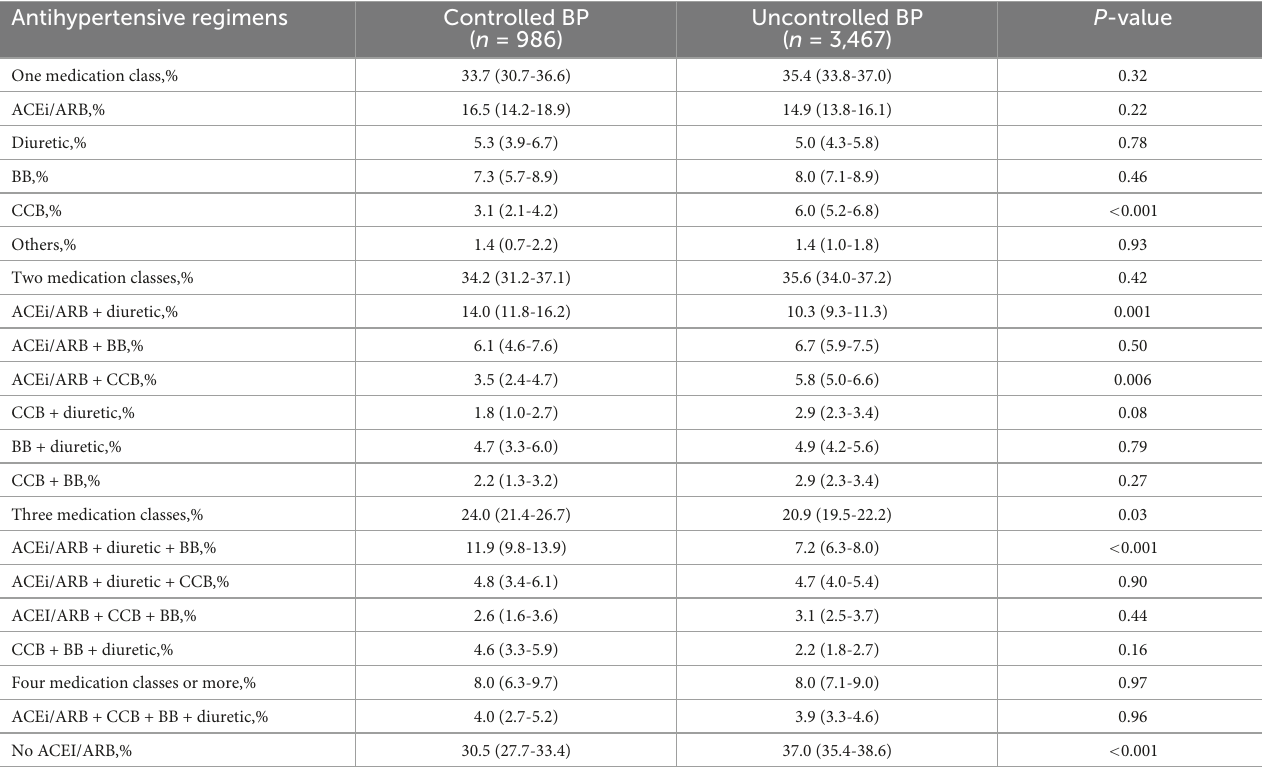
TABLE 4 Proportion of antihypertensive medication use among adult CKD patients with controlled or uncontrolled blood pressure (according to 2021 KDIGO guideline) currently taking antihypertensive agent in 2001-2018. Antihypertensive regimens Controlled BP Uncontrolled BP ( n = 986) ( n =